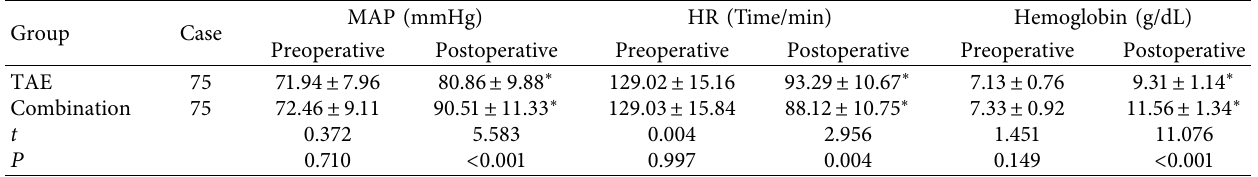
Compared with the same group before operation, ∗ P < 0 .